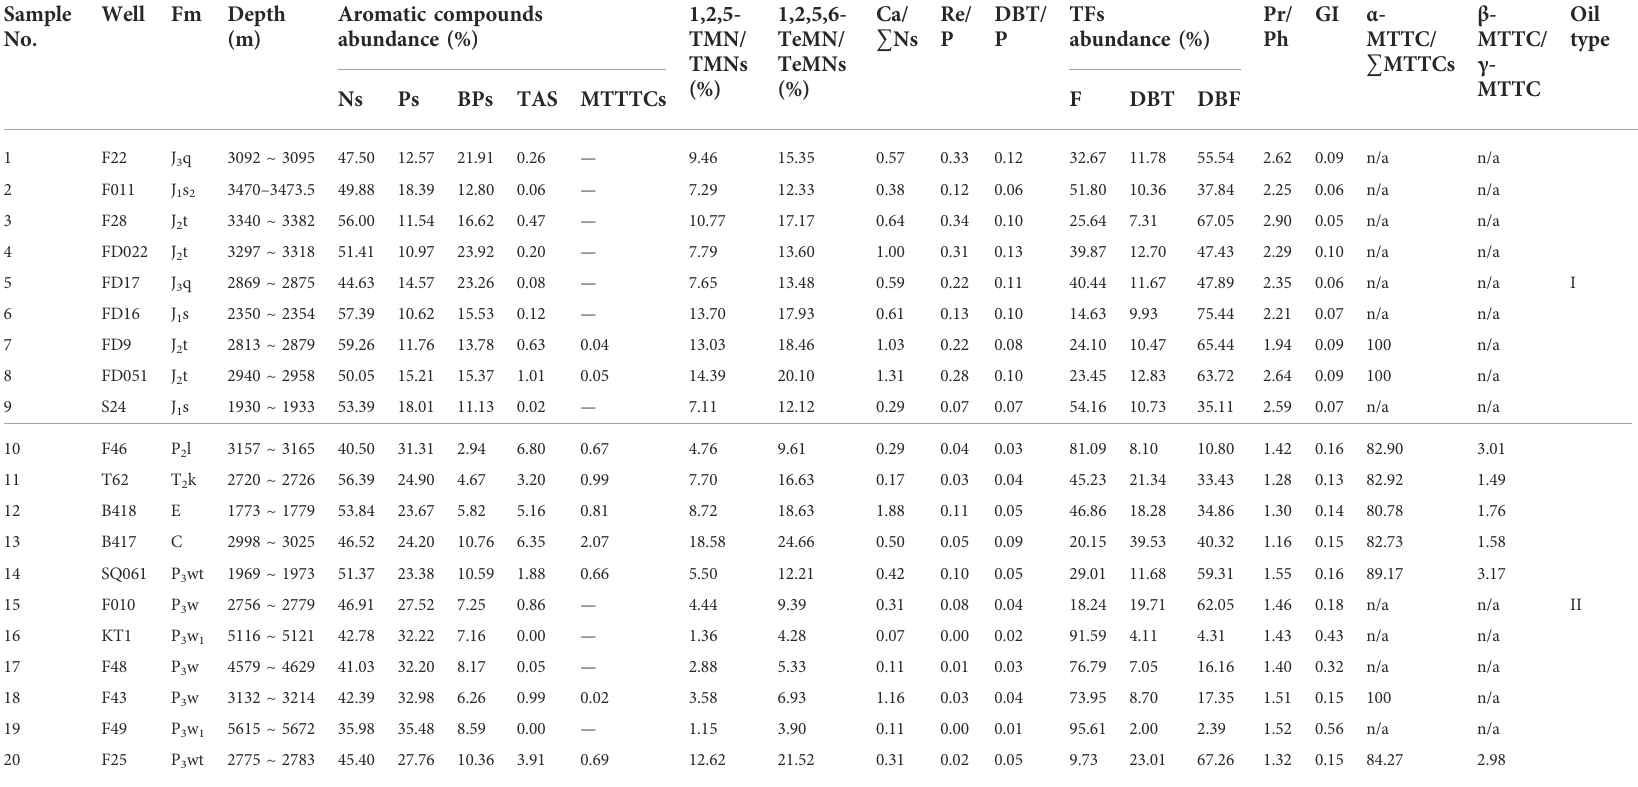
TABLE 2 Geochemical parameters of aromatic compounds in crude oil from the East Fukang Sag. Sample